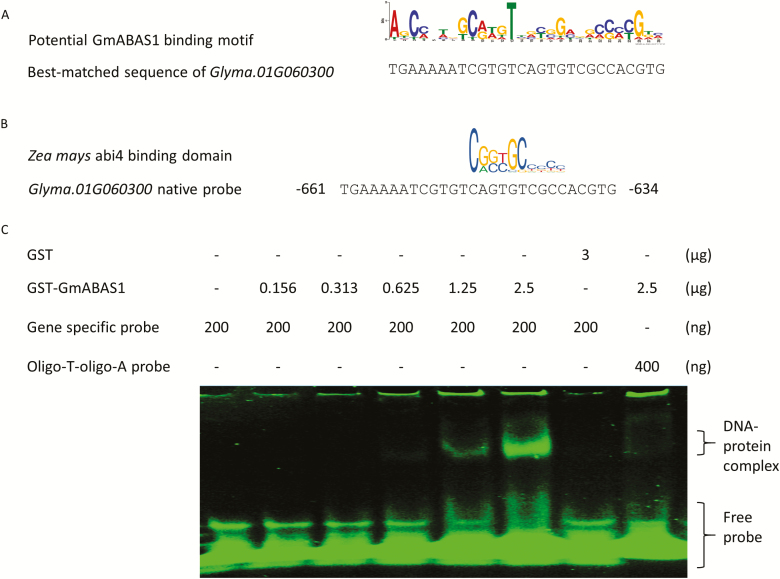
EMSA showing the binding of GmABAS1 to the promoter region of Glyma.01G060300. (A) Potential DNA motifs targeted by GmABAS1 as predicted from sequences 3 kb upstream of the translational start sites of the potential target genes of GmABAS1 (Supplementary Table S3) and the best-matched sequence upstream of the translational start site of Glyma.01G060300. (B) The best-matched sequence of Glyma.01G060300 is from 661 to 634 bases upstream of the translational start site. The motif sharing homology with the Zea mays ABI4-binding domain was mutated. (C) EMSA demonstrating the binding between GmABAS1 and the promoter region of Glyma.01G060300. GmABAS1 was purified with a GST tag. Purified GST alone or GST–GmABAS1 was incubated with gene-specific or oligo(T)–oligo(A) dsDNA probes. The incubated protein–DNA probe mixture was electrophoresed in a 6% acrylamide gel which was then stained by SYBR® Green EMSA nucleic acid gel stain. Retardation of the DNA probe migration was due to binding with GmABAS1.